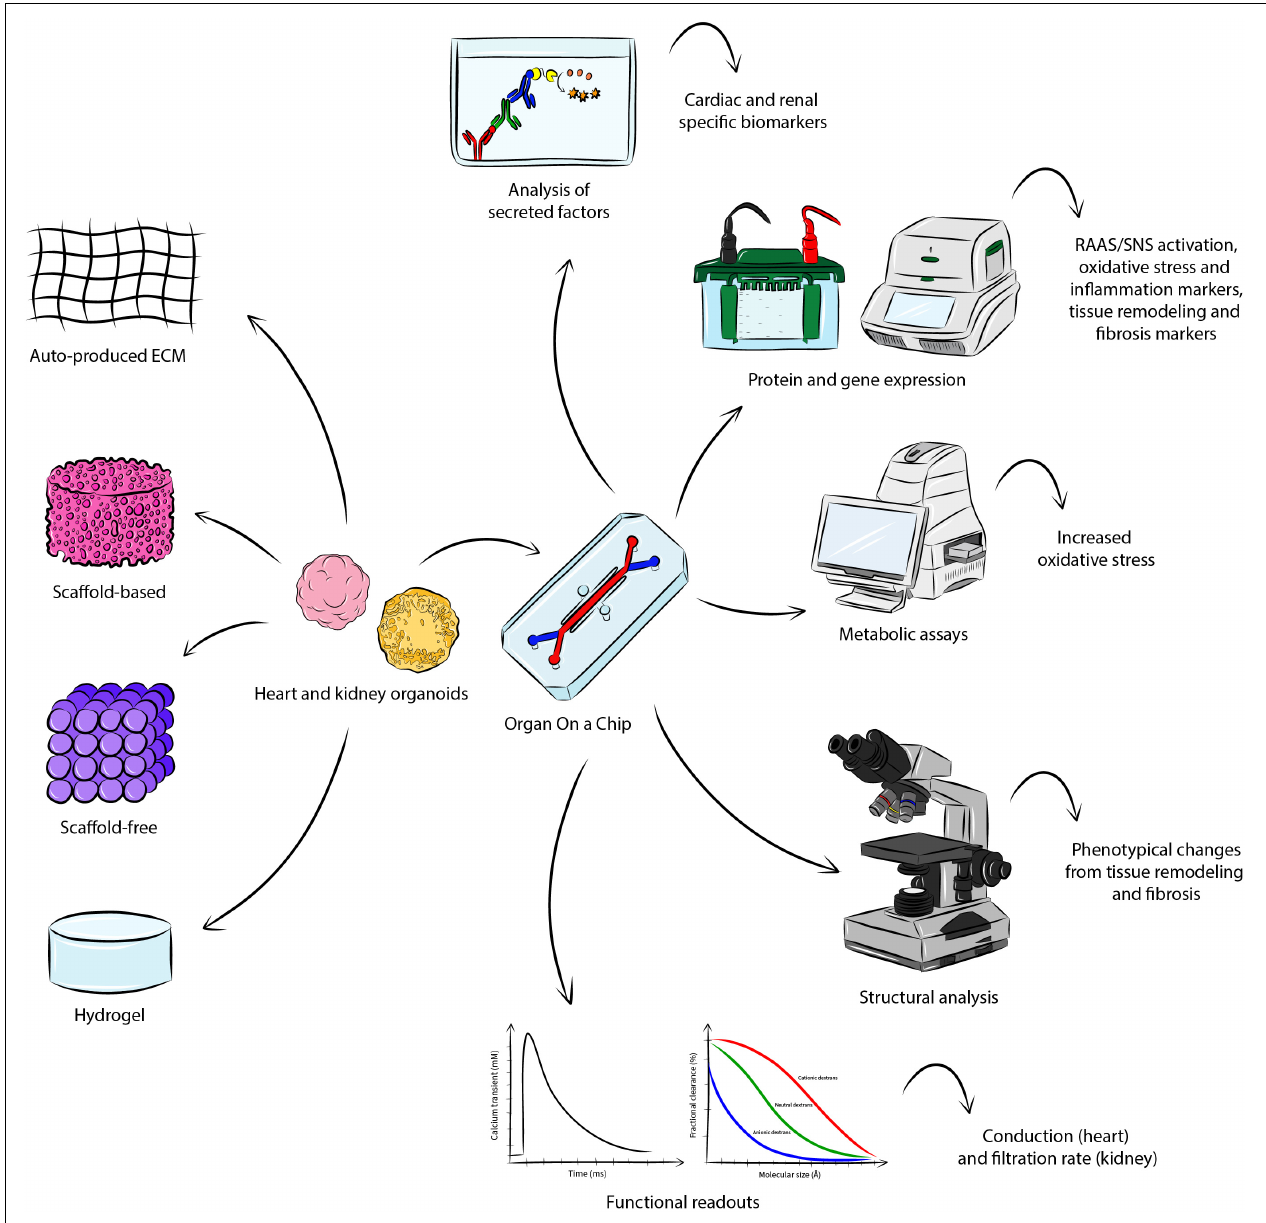
FIGURE 2 | Modeling CRS in vitro . There are several approaches for the fabrication of heart and kidney organoids, where aggregation is either based on endogenously-produced extracellular matrix, or addition of scaffold material, or hydrogel. Coupling the engineered organoid constructs into a OoC microfluidic system may allow the establishment of CRS in vitro , supporting the study of the organ-organ interaction and the measurement of important parameters identifying the hallmarks of the disease. The analysis of secreted factors could detect cardio-renal biomarkers, while protein and gene expression may be investigated though Western blot and quantitative polymerase chain reaction. Metabolic assays would serve to detect a significant change in increased oxidative stress. Structural analysis would allow the visualization of phenotypical changes in the organoids. Functional analyses specific to the organoid of interest (e.g. conduction for the heart and filtration rate for the kidney) may also be